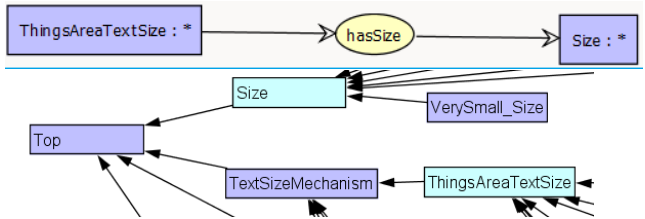
Figure 4. Excerpt of Text Style Mechanism Ontology (CoGui